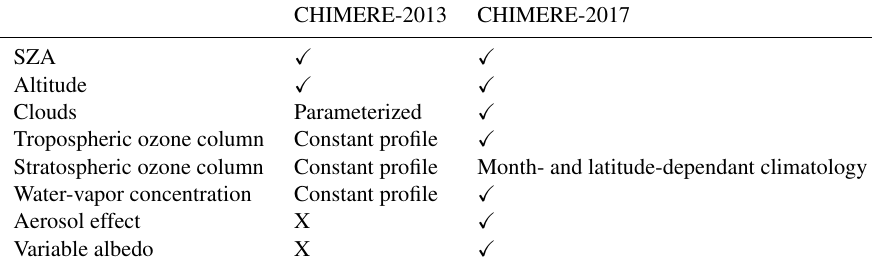
Table 3. Taking into account the various factors affecting the photolysis rates in CHIMERE-2013 and CHIMERE-2017.